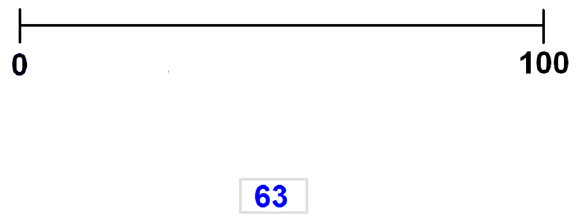
Figure 1. Illustration of the bounded number line estimation task.